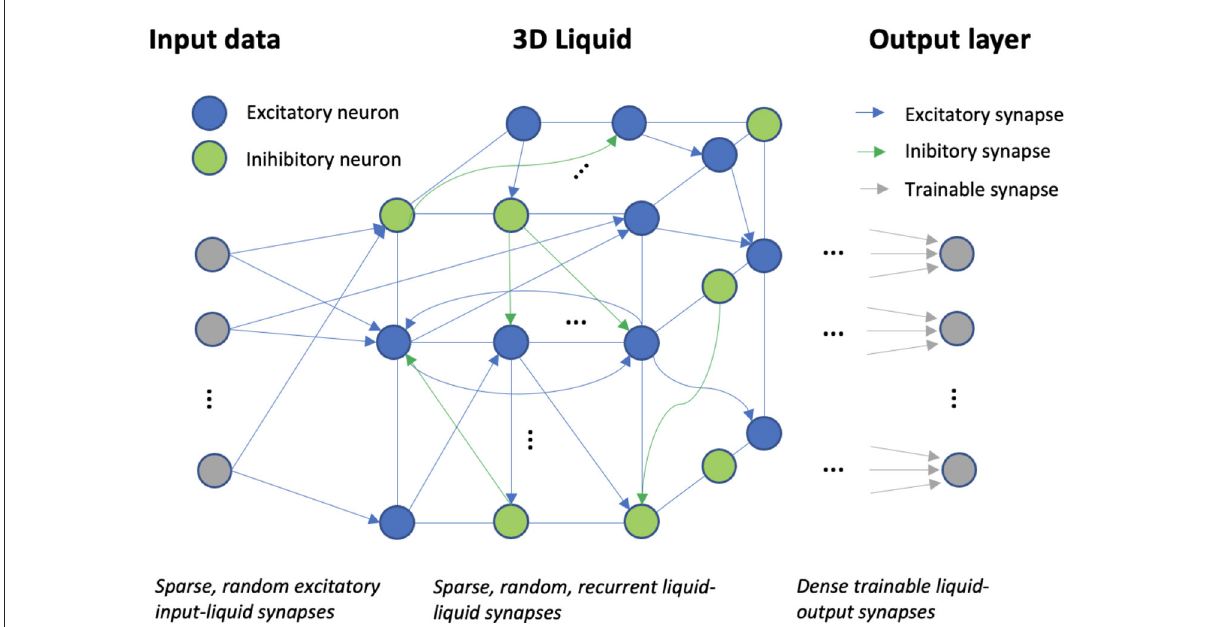
FIGURE1 The liquid state machine: input data, spread across a number of channels, is projected via fixed, sparse, random synapses onto a sparse, high-dimensional, recurrent reservoir of spiking neurons. Training of the synaptic weights only happens in the dense output layer, modeled by a logistic